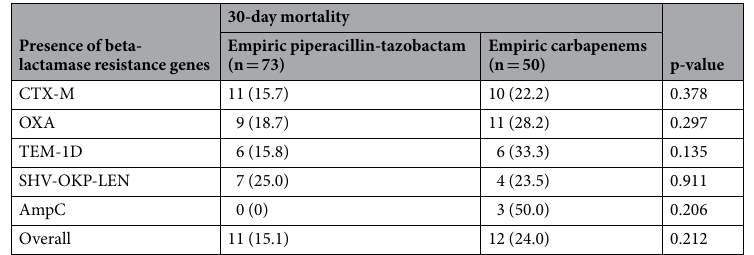
Table 2. Beta-lactamases and 30-day mortality of empiric piperacillin-tazobactam and carbapenem groups. Data are no. of patients who died